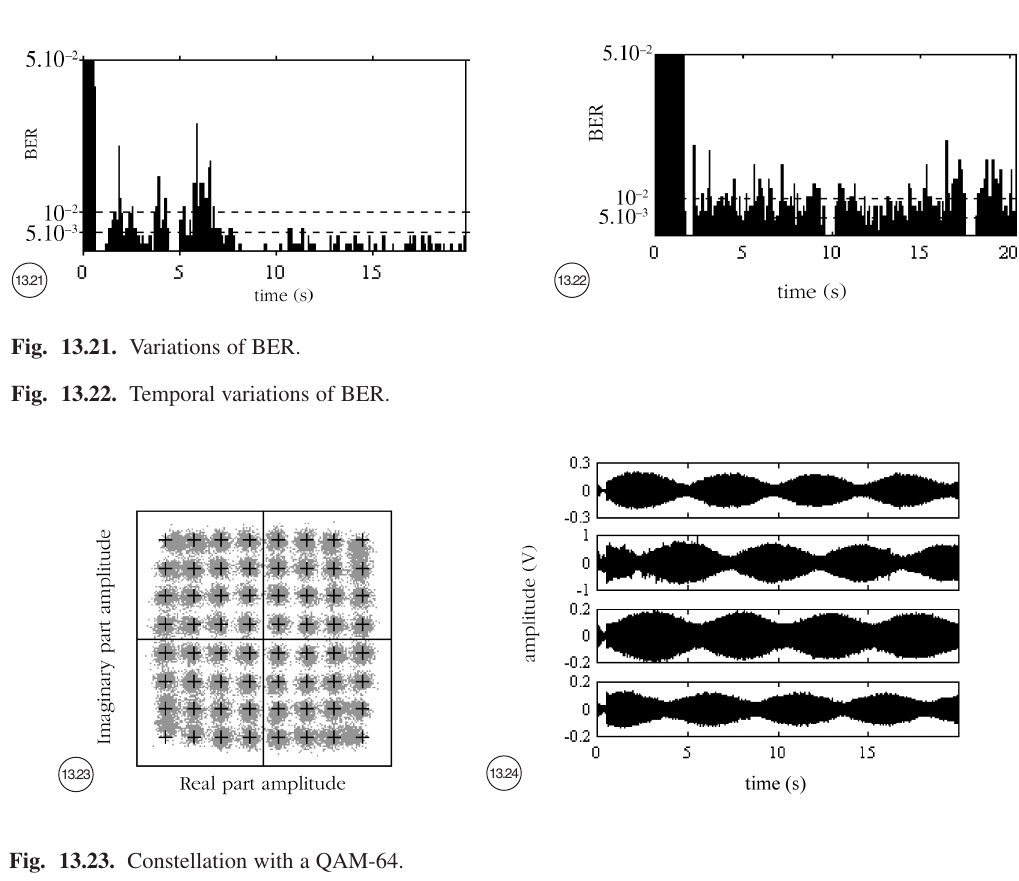
Fig. 13.23. Constellation with a QAM-64. Fig. 13.24. Signals received on the 4 collocated